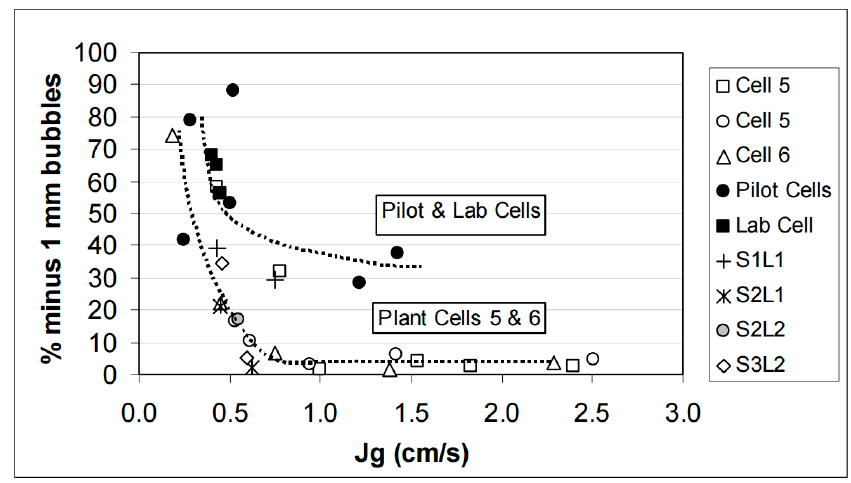
Figure 8. The percentage of <1 mm bubbles as a function of gas rate, J g , for plant cells 5 and 6 versus the pilot cells.